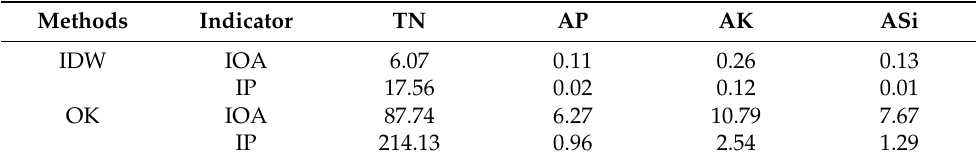
Table 5. Comparison of interpolated accuracy of different interpolation methods.